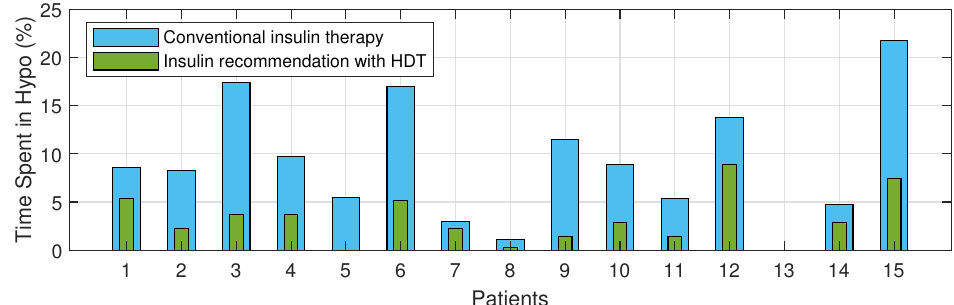
Figure 28. Percent improvement in hypo events for 15 patients with HDT.